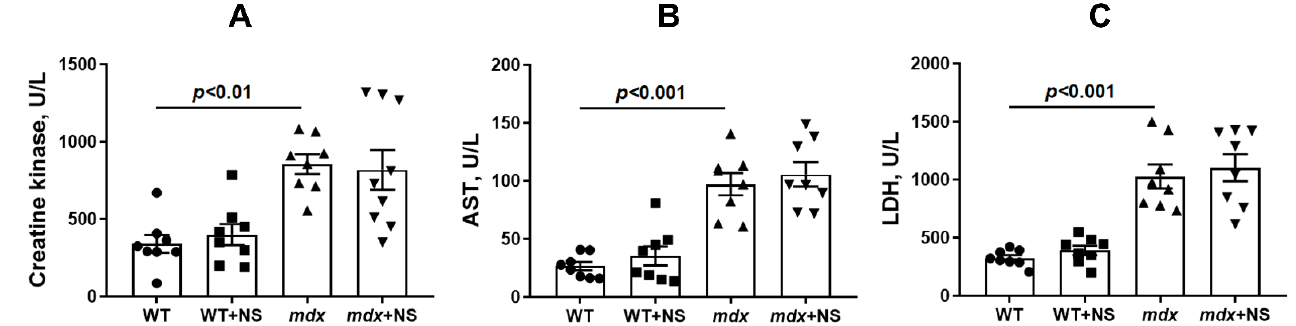
Figure 9. The effect of NS1619 on the activity of creatine kinase ( A ), AST ( B ), and LDH ( C ) in the blood serum of mice. The data are presented as m ± SEM.